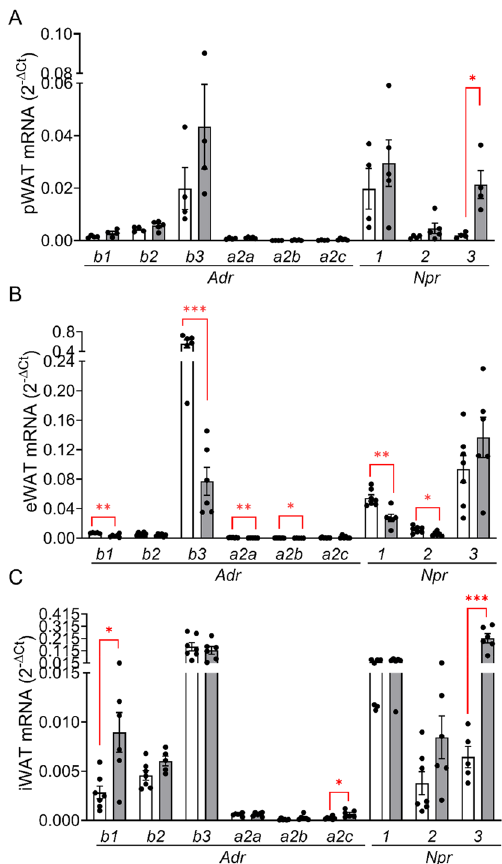
Figure 2. Expression of adrenergic and natriuretic peptide receptors in pWAT, eWAT and iWAT. Relative receptor expression (relative to Rps13 ) in ( A ) pWAT, ( B ) eWAT and ( C ) iWAT was quantified in the fat pads used in Fig. 1E-J. Results are presented as means ± SEM of n = 4–7 individual observations. * p < 0.05, ** p < 0.01, *** p < 0.001 denotes a significant diet